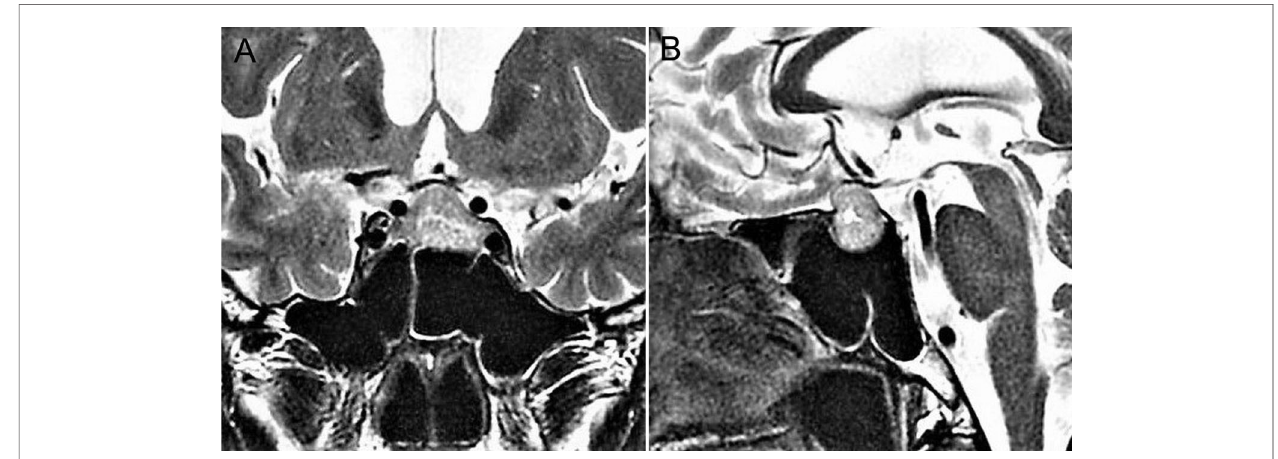
FIGURE 1 | Preoperative coronal ( A ) and sagittal ( B ) T2-weighted magnetic resonance images showing a pituitary tumor as slight hyperintensity, compressing the optic